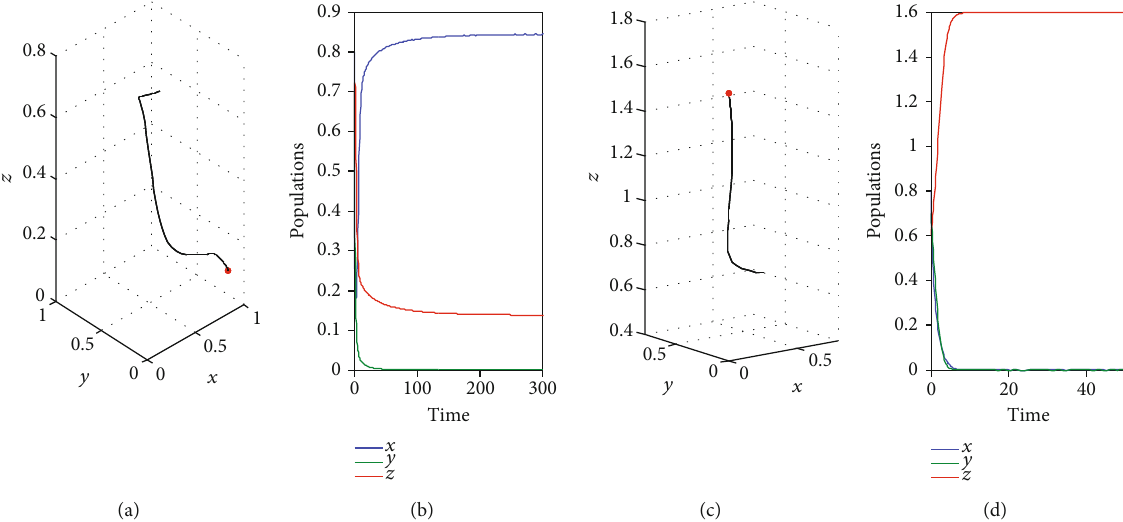
= 0 : 24 approaches asymptotically to SPFP. (b) Time series 11